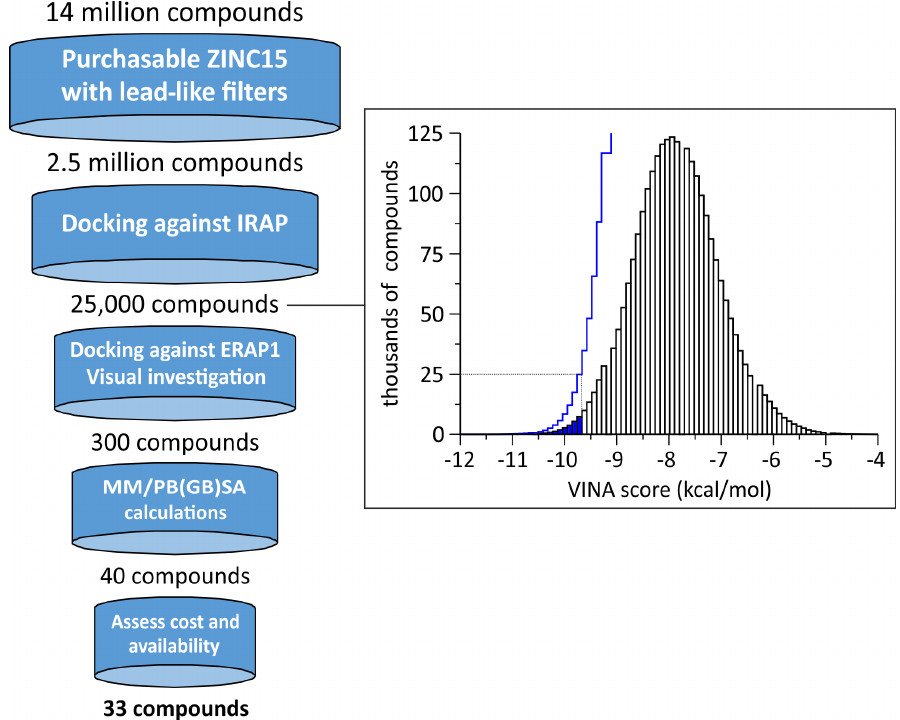
Figure 2. Virtual screening strategy employed for the discovery of lead-like allosteric inhibitors of IRAP, indicating the approximate number of compounds used in each stage. Inset, the distribution of number of compounds (in thousands) as a function of estimated free energy of binding (VINA score). The blue line shows the cumulative distribution and the highlighted region indicates the top 1% (lowest energy) of the compounds selected.